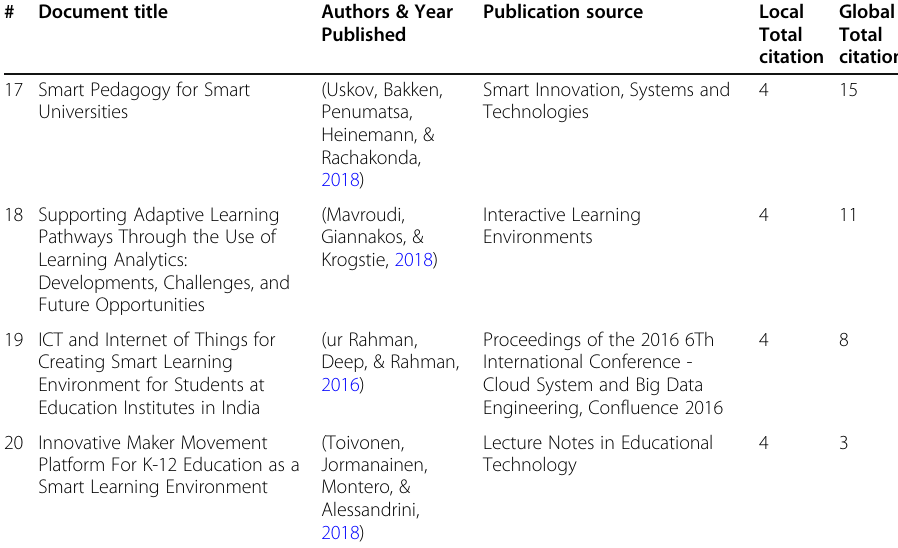
Table 5 Top twenty most cited references based on number of local citations from the collection dataset